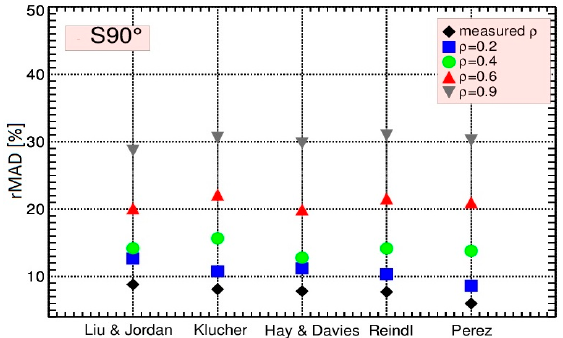
Figure 7. Same as Figure 6, but for 90° S. The rMAD increase as the albedo value increases. The plot illustrates albedo values on vertical tilted irradiance.